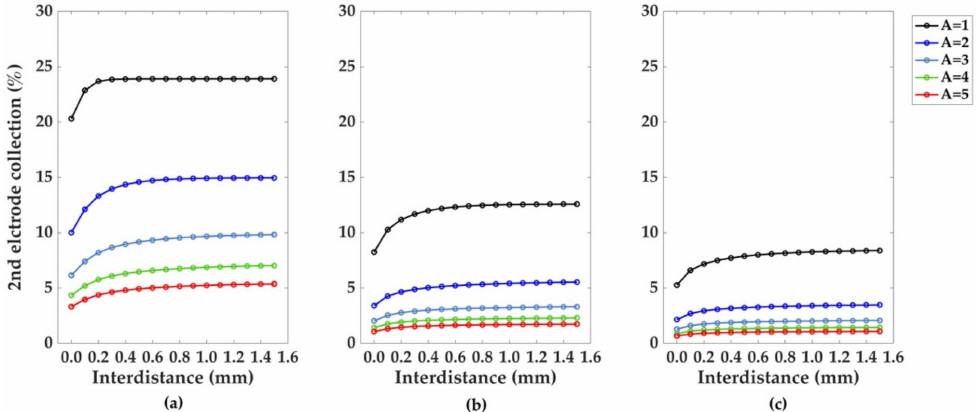
Figure 10. Trail effect. Dimensional model for the collection percentage at the second electrode, bumped configuration: ( a ) Pe = 10, ( b ) Pe = 50, ( c ) Pe = 100. Channel heights A = 1, 2, 3, 4, and 5, du were considered for the modeling and conversion to dimensional units. As for the monoelectrodic case, greater A values brought a reduction in the collection percentage of electroactive species at the second